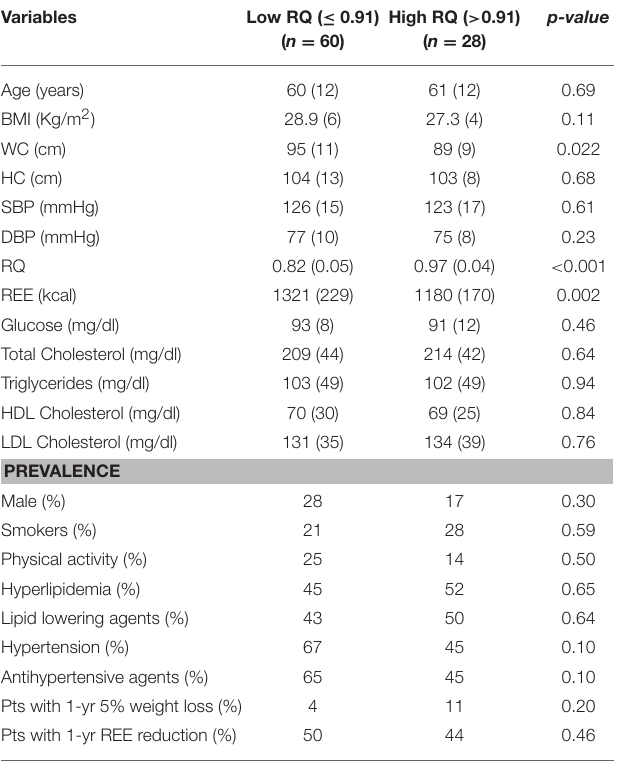
TABLE 1 | Baseline participant’s demographic, anthropometric, and clinical characteristics of the population according to low and high respiratory quotient. Variables